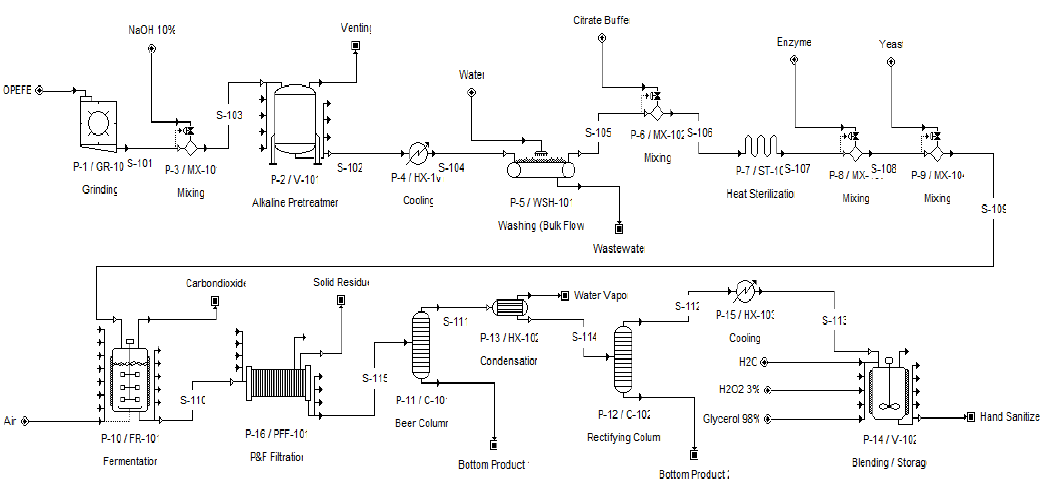
Figure 2. Complete process flow diagram of hand sanitiser production from OPEFB-based bioethanol in SuperPro Designer ® v9.0.